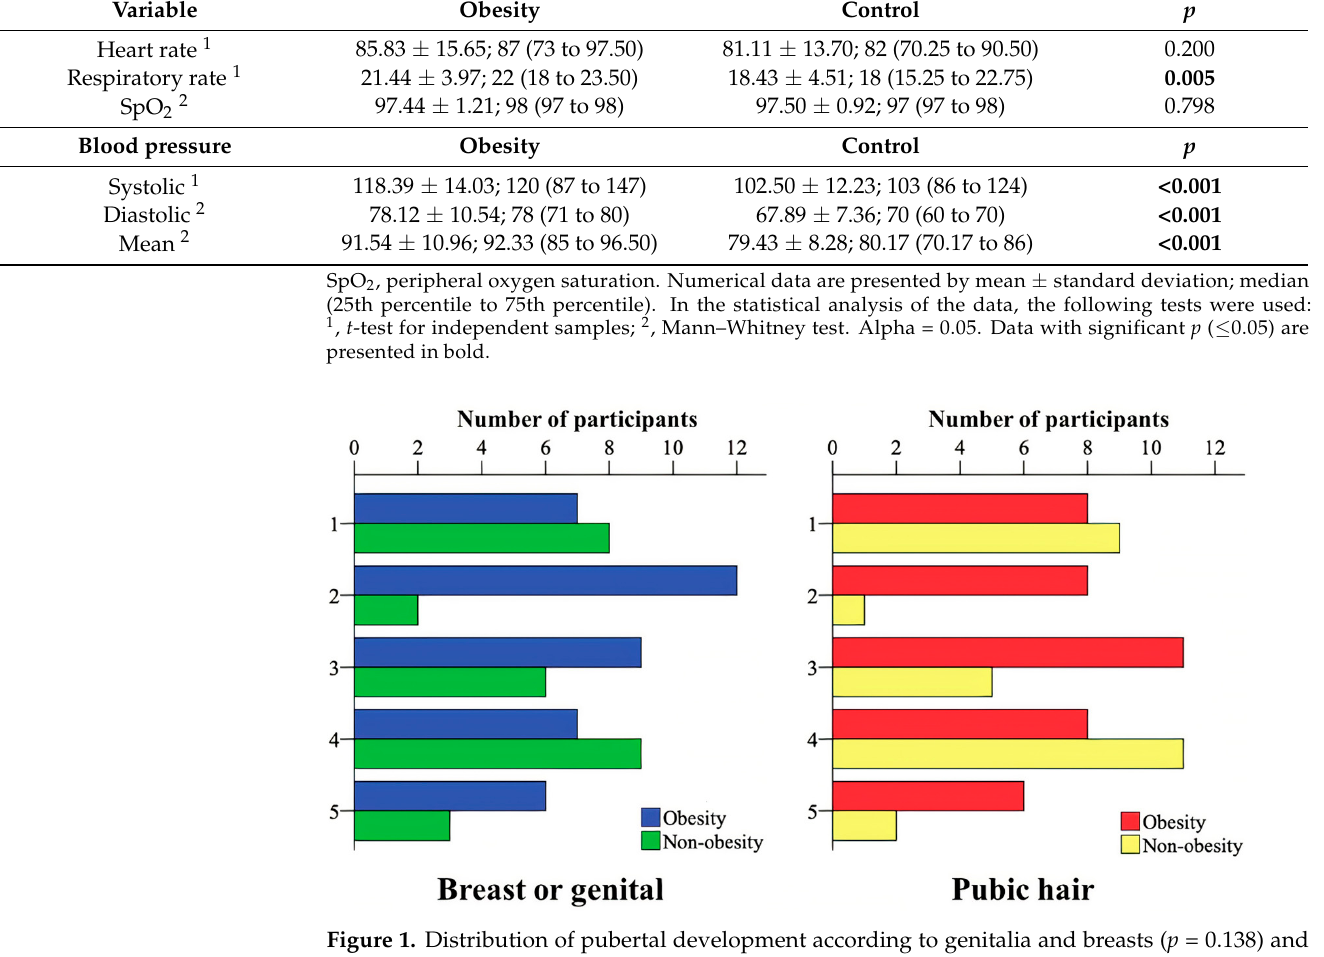
Table 3. Comparison between the vital signs of participants with and without obesity.